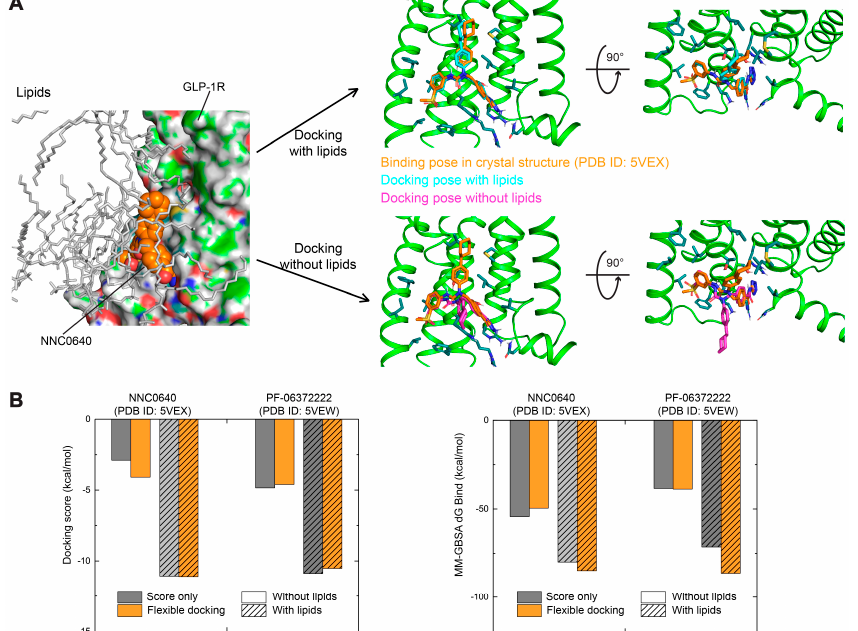
Figure 2. Evaluation of molecular docking protocols on re-docked negative allosteric modulators NNC0640 and PF-06372222 to the allosteric extra-helical binding site of GLP-1R [7]. ( A ) Comparison of docking poses of NNC0640 in GLP-1R by docking protocol with or without the consideration of lipids. The crystal structures of human GLP-1R TMD in complex with PF-06372222 (PDB code: 5VEW) [7] and NNC0640 (PDB code: 5VEX) [7] were obtained from the Protein Data Bank [36]. Carbon atoms of NNC0640 in crystal structure [7], traditional Glide XP docking and Glide XP docking within lipids are colored orange, cyan and magenta, respectively. ( B ) Comparison of docking scores and calculated binding free energies (MM-GBSA dG Bind) of NNC0640 and PF-06372222 to GLP-1R with or without considering the lipid contribution. Molecular docking and binding free energy calculation were performed using Glide and Prime MM-GBSA modules in Schrödinger Suite 2017-3, respectively. Docking score and MM-GBSA dG Bind are in kcal/mol.